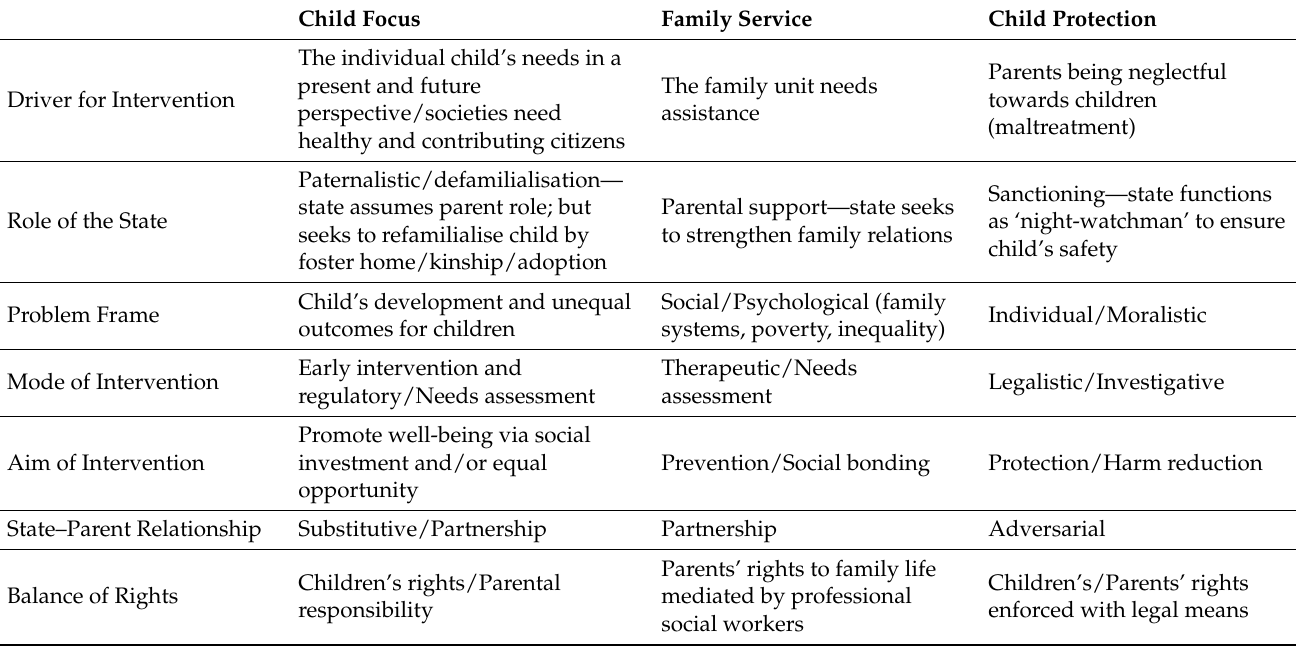
Table 2. Three Orientations on the Role of the State vis à vis Child